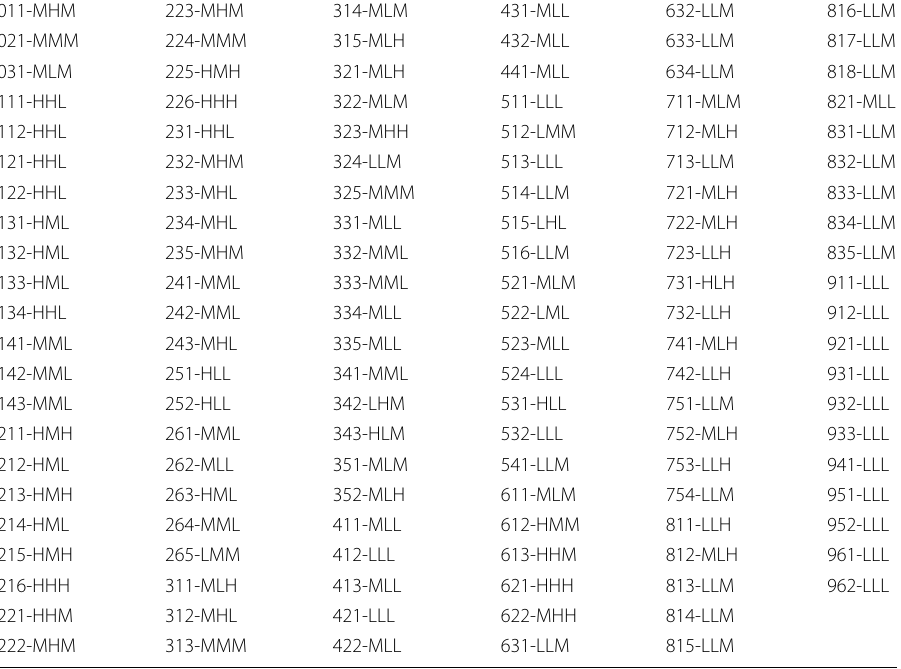
L, low; M, moderate; H, high. E.g., 214-HML means that ISCO code 214 corresponds to high data complexity, moderate people complexity and low things